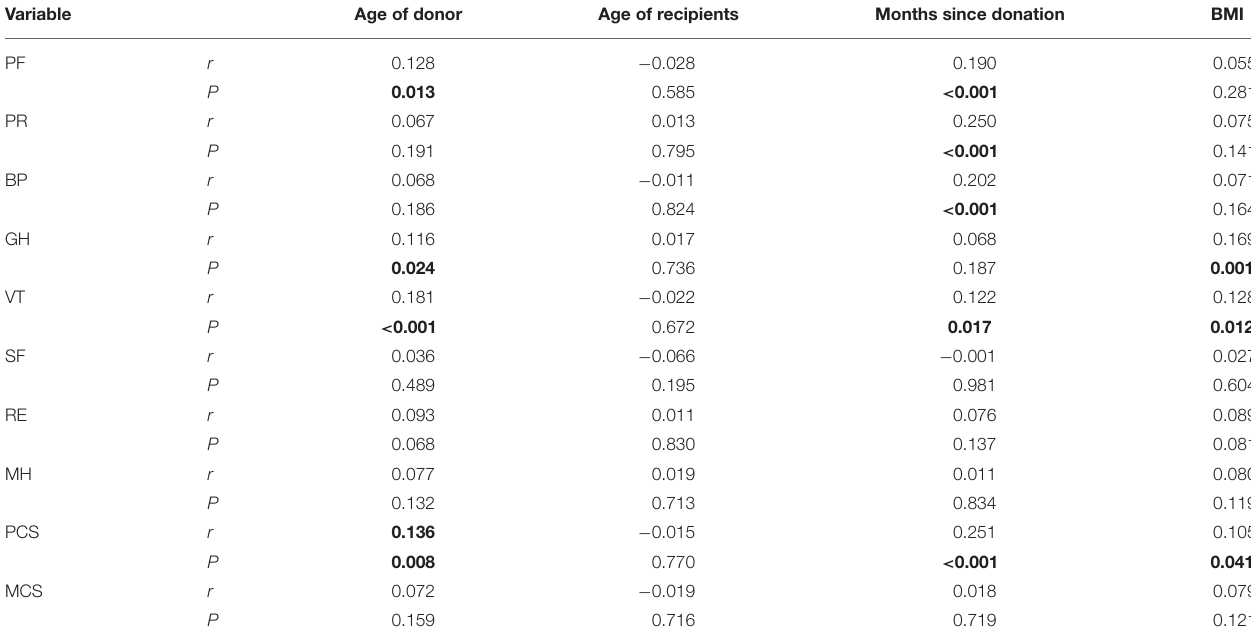
TABLE 6 | Bivariate correlations for continuous variables ( n = 382). Variable